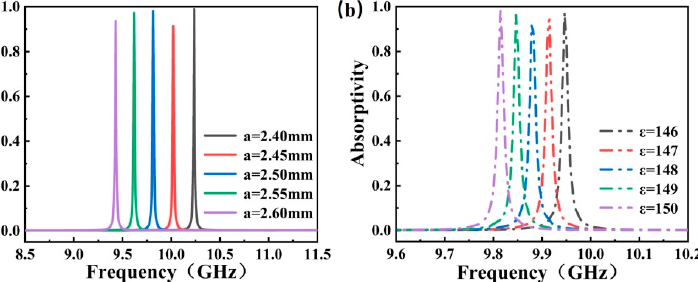
Figure 6. ( a ) simulated absorptivity spectra when a = 2.40-2.60 mm, ε = 150; and ( b ) simulated absorptivity spectra when a = 2.50 mm, ε = 146 – 150.